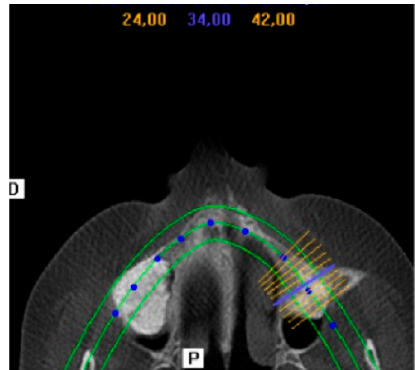
Figure 6. i-CAT (Imagen-computerized axial tomography) Vision postoperative image. It shows increased volumes produced by the xenograft procedures after six months of maxillary sinus elevation with a porcine hydroxyapatite (cuts 24–42).